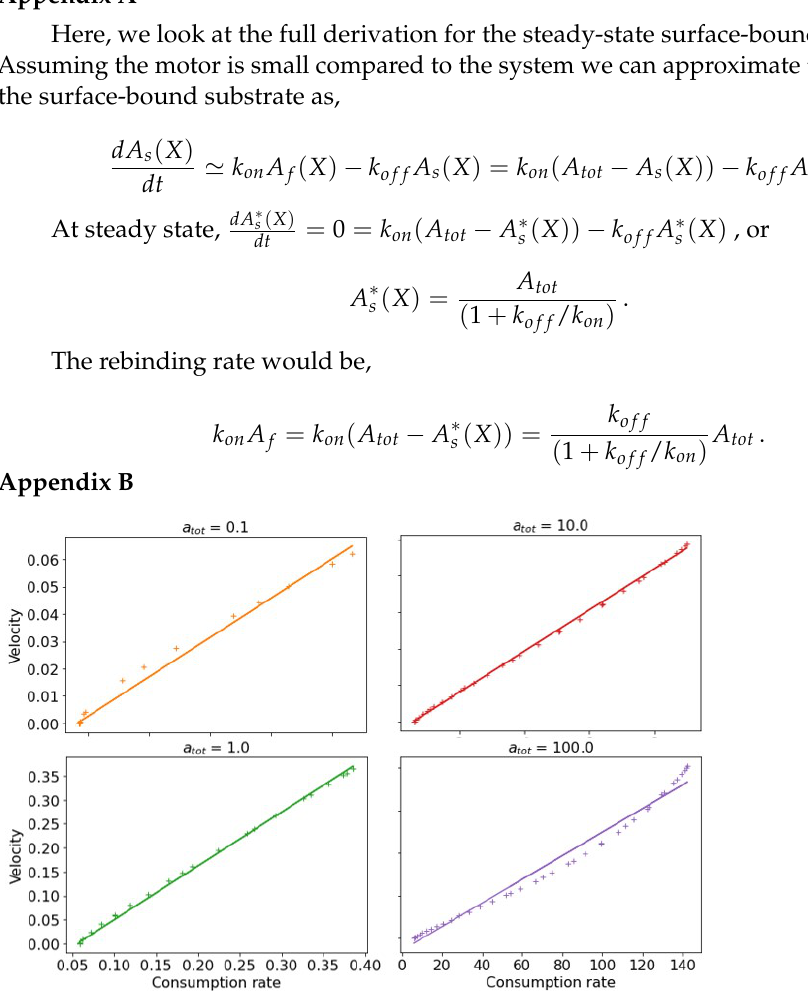
Figure A1. Velocity scaling with consumption rate. Velocity as a function of consumption rate for different a tot . Crosses represent simulated results. Lines represent a linear fitting. At substrate concentrations of less than 0.1 the hub was stalled leading to velocities below computational